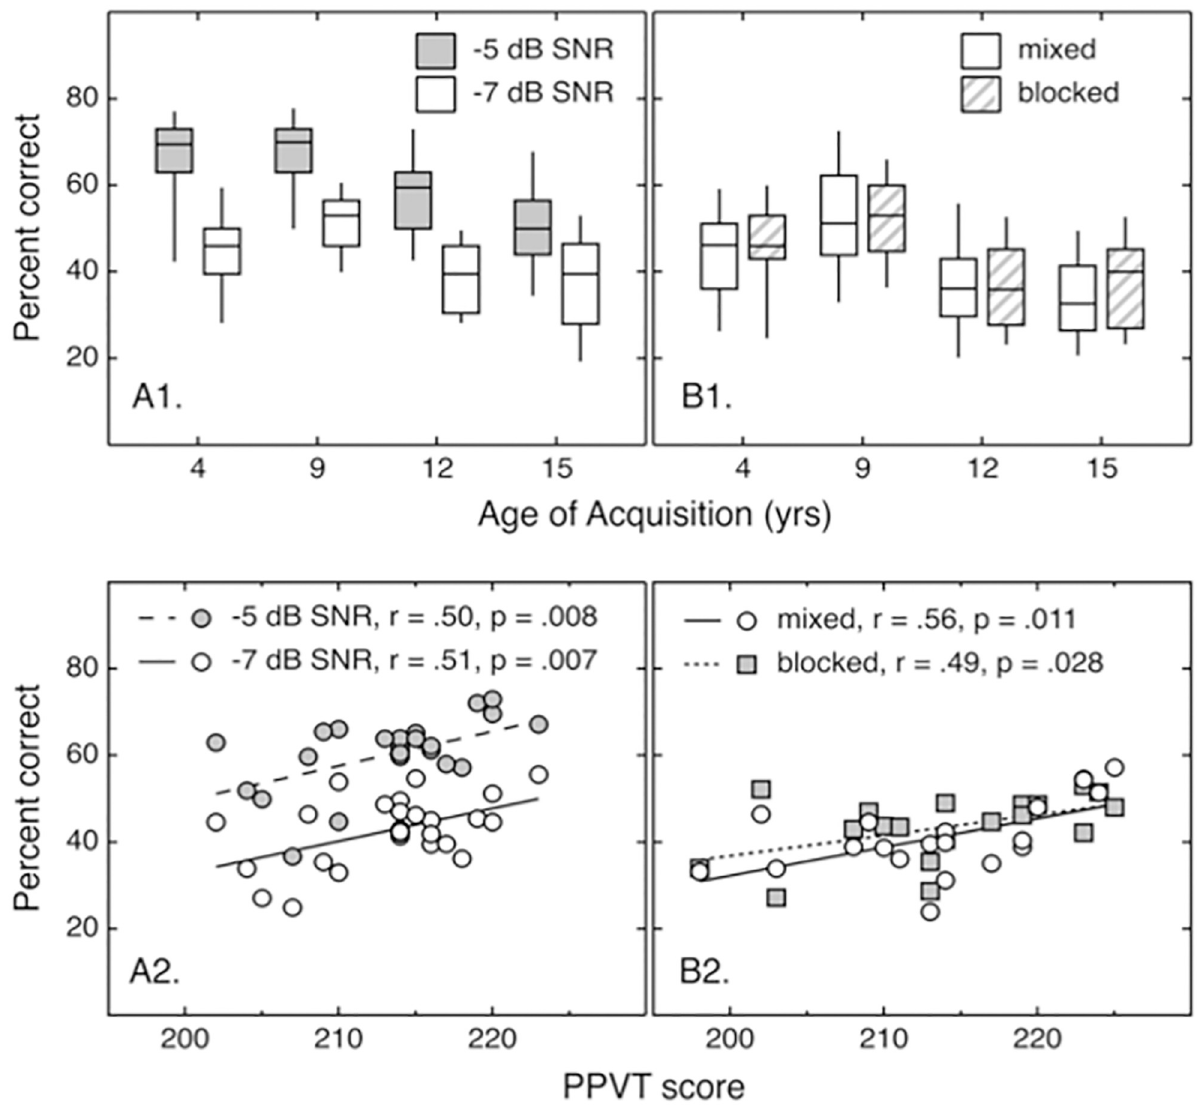
Fig 2. Word scores by AoA and PPVT scores. Panels A1 and B1 show the distribution of word scores, plotted as a function of AoA. The horizontal lines indicate the medians, boxes span the 25th to 75th percentiles, and whiskers span the 10th to 90th percentiles. Panels A2 and B2 show the mean SRT for individual listeners, plotted as a function of their receptive vocabulary (PPVT score). Lines indicate the association between percent correct and receptive vocabulary. Box and symbol fill reflects SNR (A1 & A2, Exp 1) or mixed vs. blocked wordlists (B1 & B2, Exp 2), as defined in the legend. All testing in Exp 2 was conducted at -7 dB